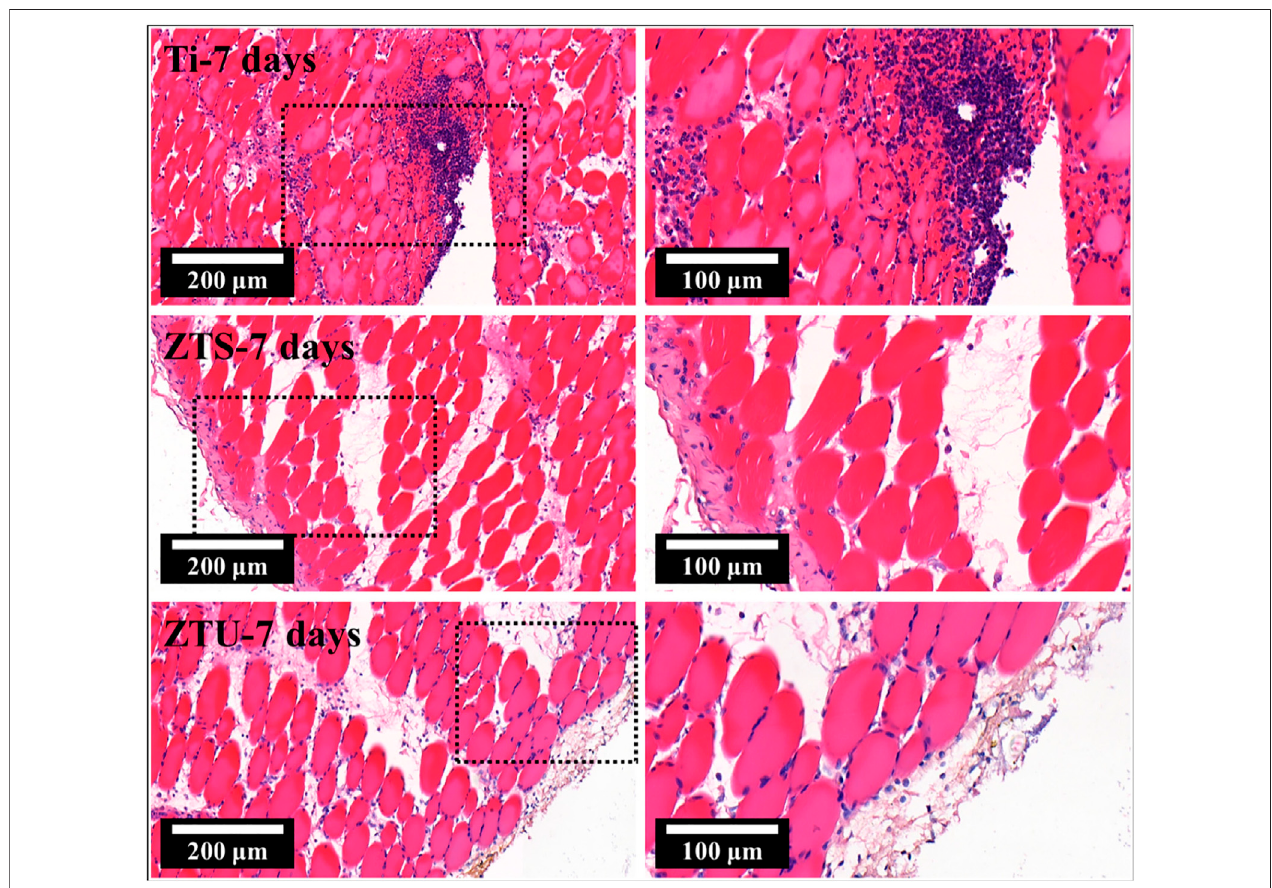
FIGURE 11 | Pathological photographs of Zn-modi fi ed TiO 2 photocatalysts. Adapted from Lv et al. (2021). Copyright © 2021 Elsevier B.V.